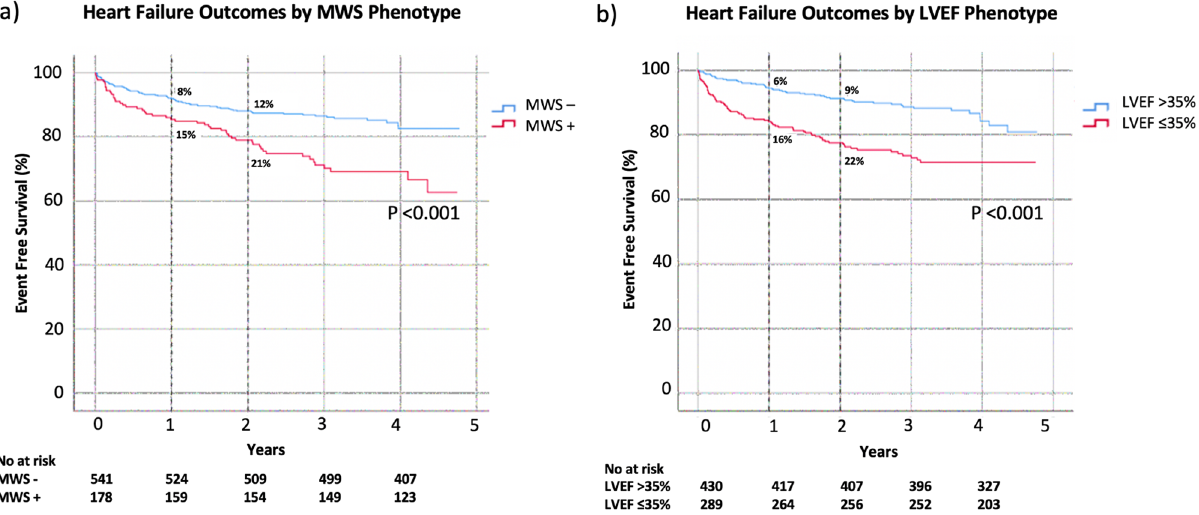
Figure 5. Kaplan–Meier event free survival curve for the secondary heart failure composite outcome of heart failure hospitalization in patients with and without ( a ) mid-wall striae (MWS) fibrosis, and ( b ) LVEF ≤